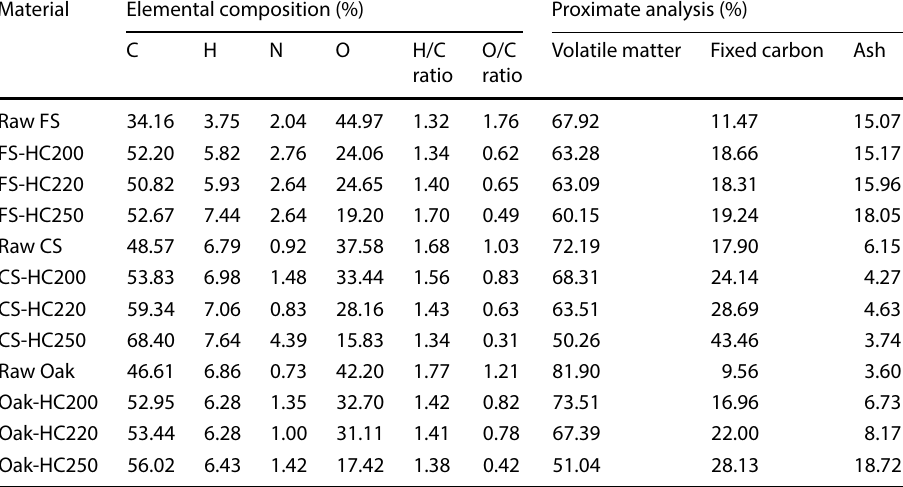
Table 3 Elemental and proximate analysis of